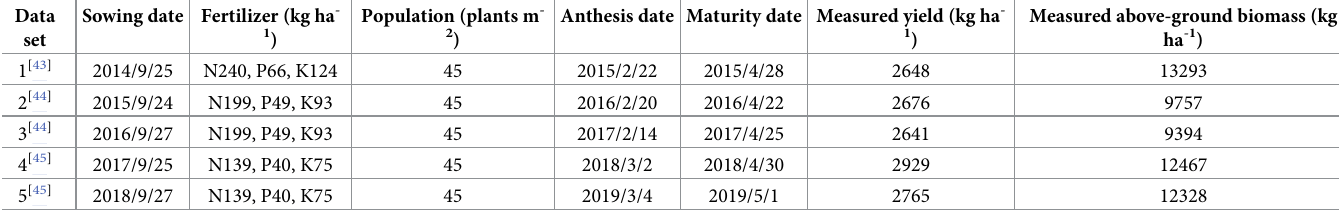
Table 4. Datasets for calibration (1–2) and evaluation (3–5) of CROPGRO-Canola model. Data Sowing date Fertilizer (kg ha - 1 set